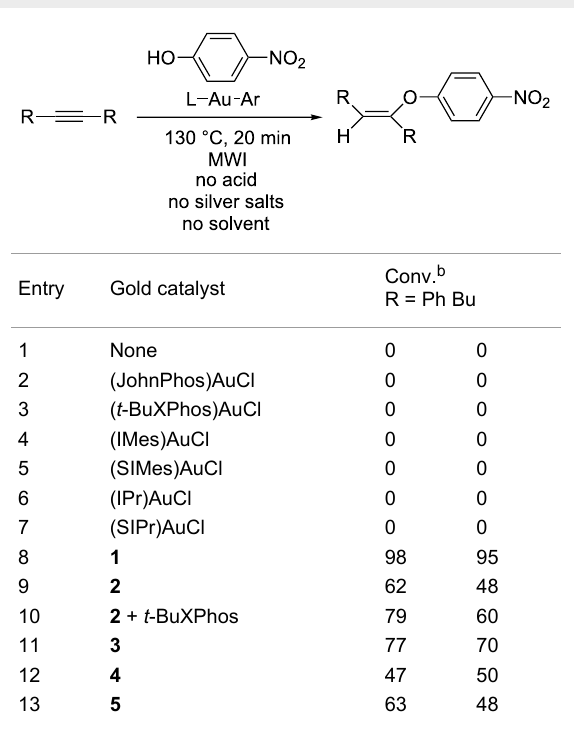
Table 1: Hydrophenoxylation of unactivated internal alkynes. a